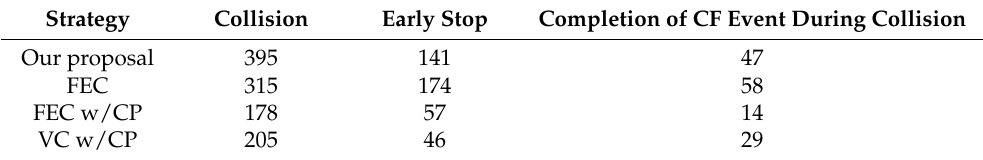
Table 3. CF situations with different strategies in collision episodes achieved during training.